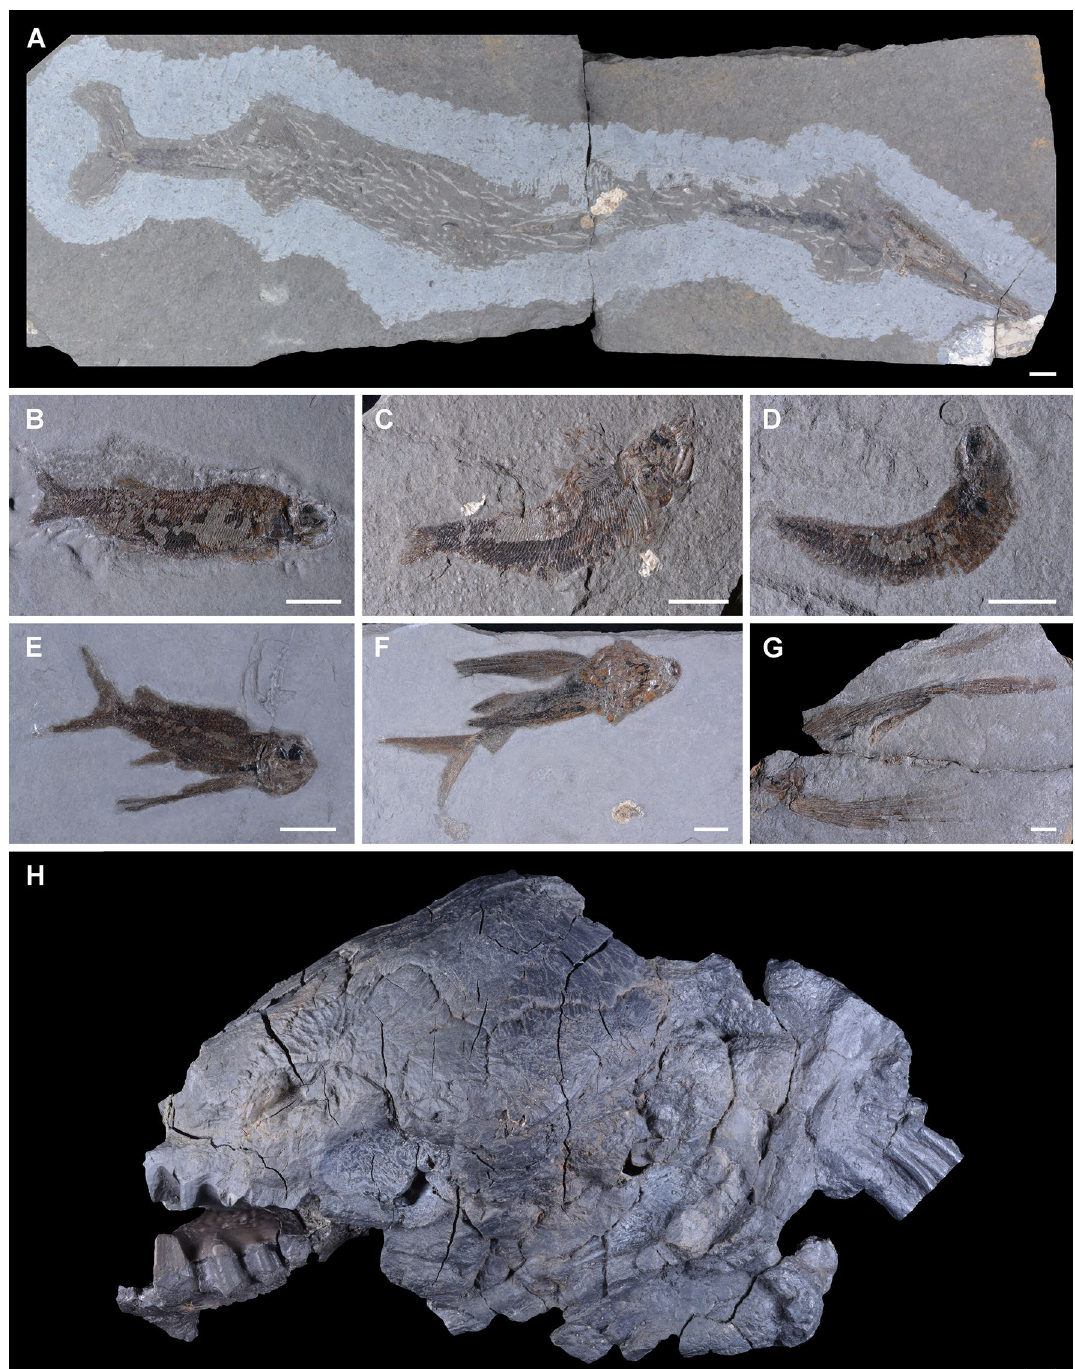
Figure 4. Vertebrate members of the Lower Carnian (Upper Triassic) Polzberg palaeobiota. ( A ) Saurichthys calcaratus , lateral view, NHMW 2007z0170/0001; ( B ) Nannolepis elegans , NHMW 2007z0170/0147; ( C ) Nannolepis elegans , NHMW 2007z0170/0148; ( D ) Habroichthys gregarius , NHMW 2007z0170/0071; ( E ) Thoracopterus niederristi , NHMW 2007z0170/0171; ( F ) Thoracopterus niederristi , NHMW 2007z0170/0172; ( G ) Gigantopterus telleri , NHMW 2007z0170/0366; ( H ) Tellerodus sturii , cast of GBA 1891/001/0001. Scale bar: 10 mm. Prepared by AL using CorelDRAW X7; www. corel draw.